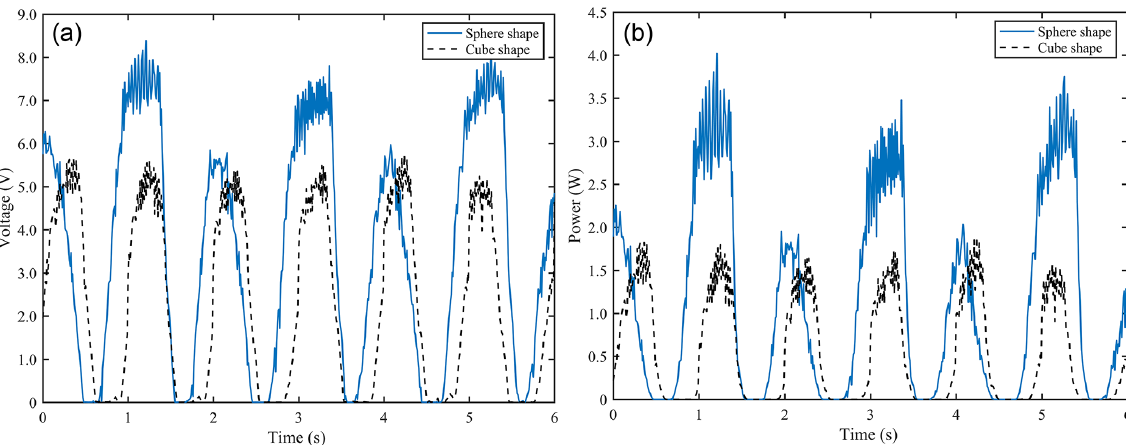
Figure 8. Energy efficiency characteristic curves of the spherical and square floating bodies. (a) Voltage curve. (b) Power curve.